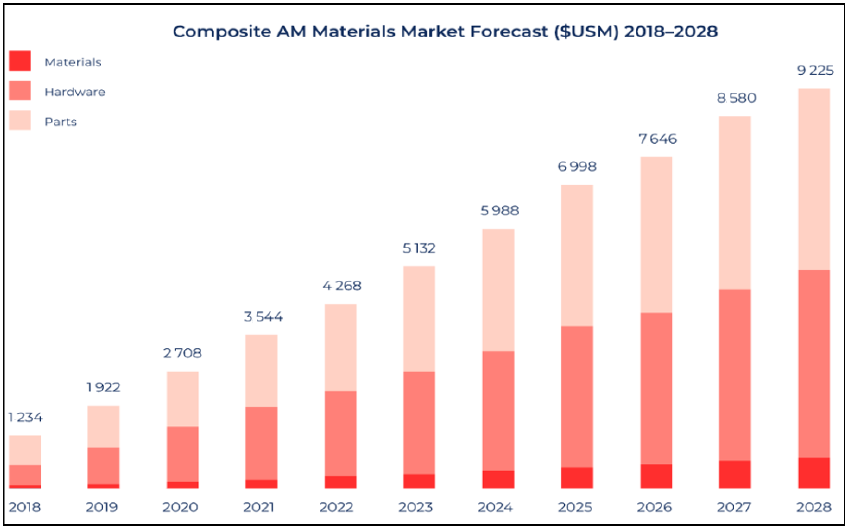
Figure 11. Growth in additive manufacturing of composites [43].